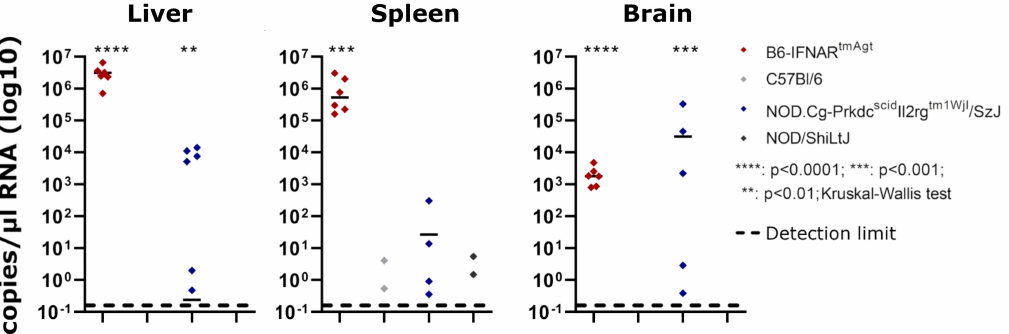
Figure 2. Comparisons of PCR results in B6-IFNAR tmAgt and NOD.Cg-Prkdc scid Il2rg tm1Wjl /SzJ mice: RT-qPCR results of both mouse strains show significant viral loads in liver, spleen and brain when compared to RVFV-infected wildtype controls (C57Bl/6 or NOD/ShiLtJ mice, respectively). Five of twelve (42%) RVFV-infected B6-TLR7 tm1Aki and three of twelve (25%) RVFV-infected C.129S7(B6)-lfng tm1/s /J mice, respectively, exhibited small (4.4 × 10 − 1 –2.54 × 10 1 copies/ µ